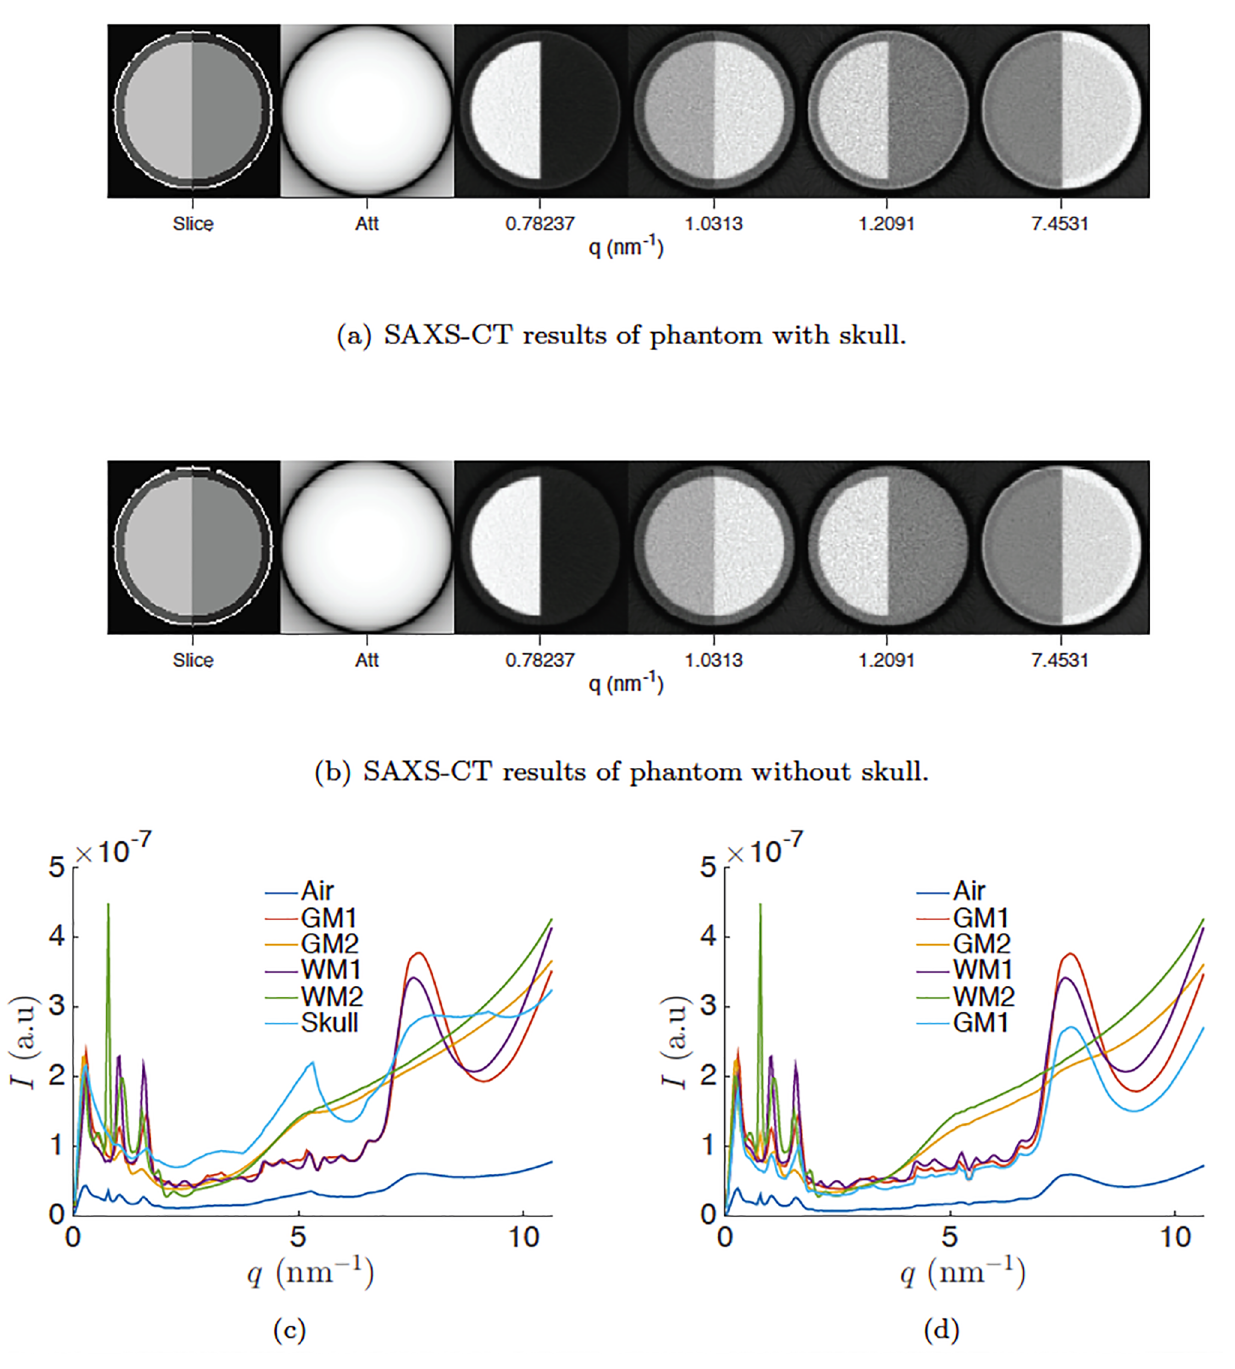
Fig 7. (a) Results from SAXS-CT simulations using MC-GPU. First image is a map of materials(same as Fig 1(a)). The second image is the attenuation image that a typical CT image would produce. The third and sixth images are intensity maps reconstructed from a specific q angle indicatedbelow the image. (b) Results of SAXS-CT simulations with the skull replaced by GM2. (c-d) Using the material map in the first image, we averagedpixels belongingto a particularmaterialand plotted cross sections of each material (c with skull, d without skull).